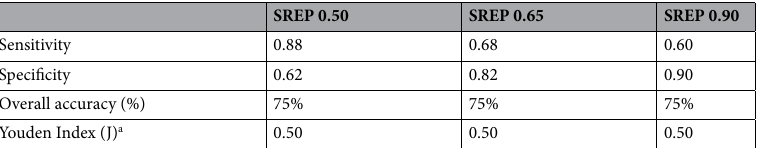
Table 3. Sensitivity and specificity values, overall accuracy and Youden index for the three selected SREP cut- off points (0.50, 0.65 and 0.90) for discriminating between EM and healthy individuals. SREP slowly, repeated evoked of pain. a Youden Index (J) = Sensitivity + Specificity − 1.